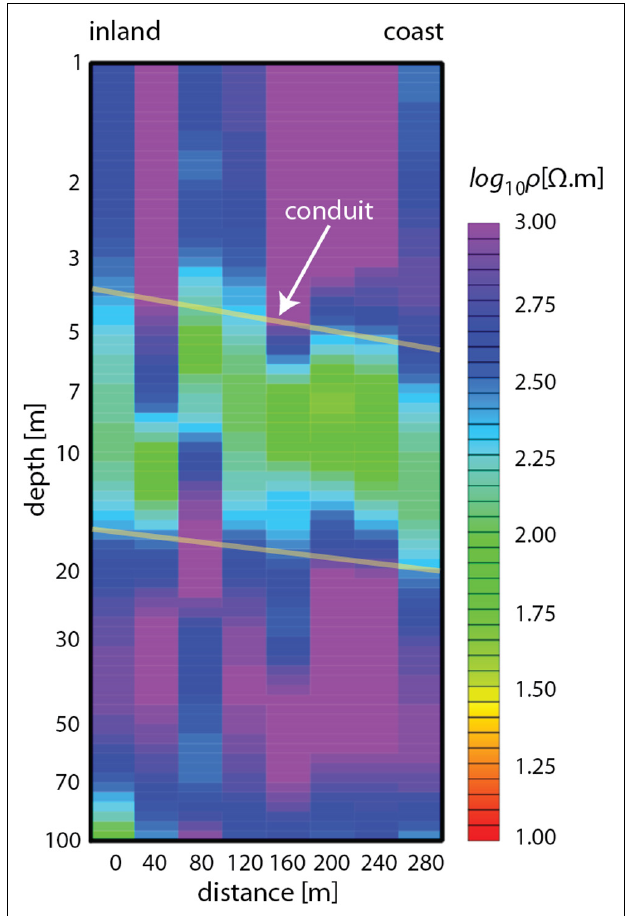
FIGURE 11 | Plot of the 40 × 40 m G-TEM 1D stitched inversion section from the head of the box canyon (0 m) moving inland (280 m). Refer to Figure 4 for the survey location. The interpreted conduit is highlighted in light green colors between the yellow lines.